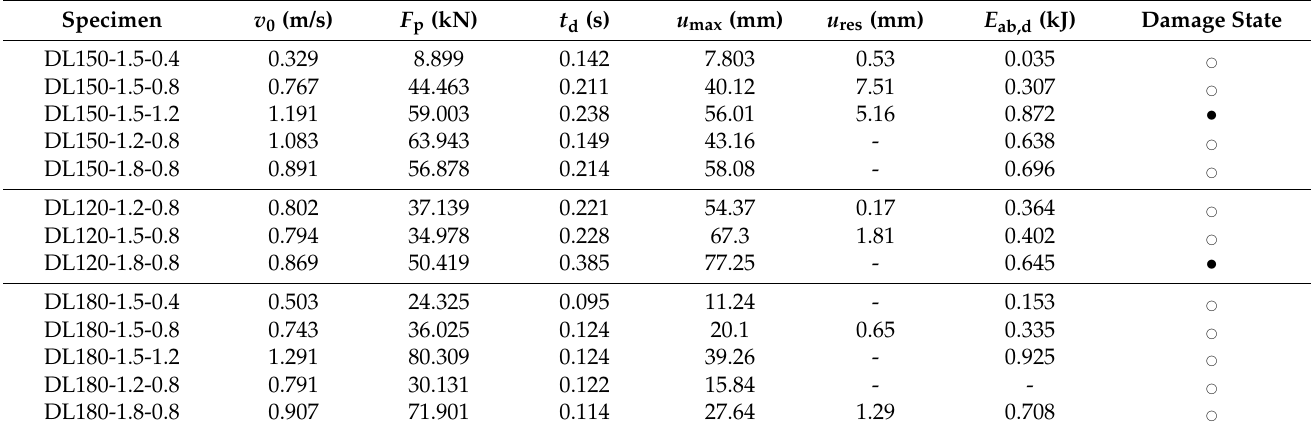
Table 2. Details of the specimens and impact test